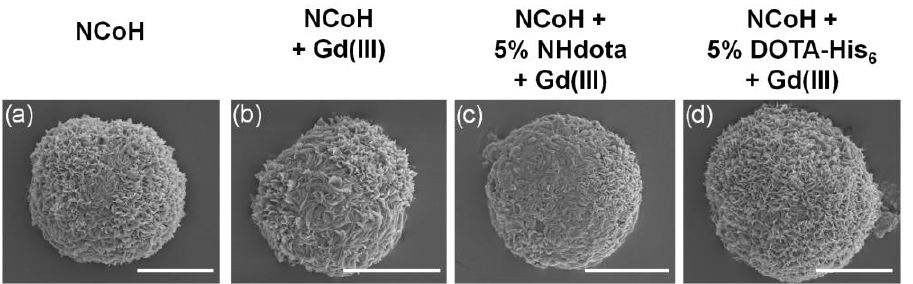
Figure 3. Scanning electron microscopy images of microflorettes generated with ( a ) 1 mM of NCoH and 400 µM of Zn(II), ( b – d ) followed by the addition of Gd(III) to pre-formed microflorettes composed of ( b ) NCoH , ( c ) 5% NHdota and ( d ) 5% DOTA-His 6 (scale bars = 10 µm). Table 1. Analysis of zinc and gadolinium ions within microflorettes by ICP-MS.